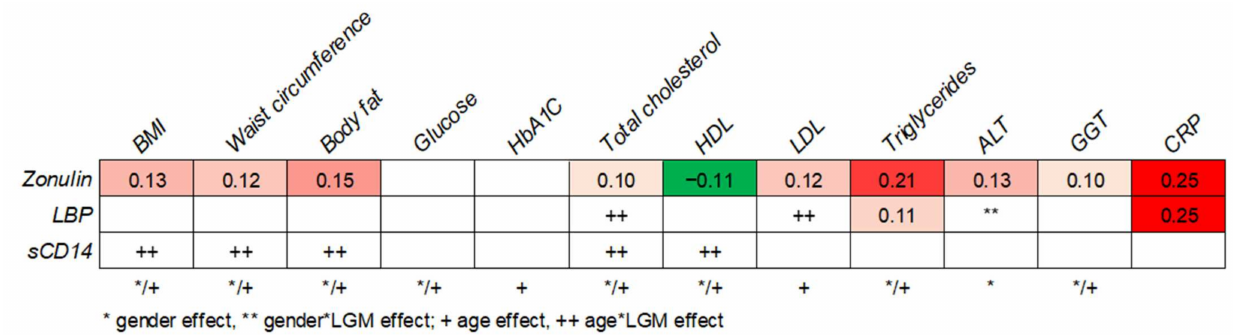
Figure 1. Stepwise linear regression analyses to test the relationship between leaky-gut markers (LGMs) and metabolic mark- ers. BMI: body mass index; HbA1c: glycated hemoglobin A1c, HDL: high-density lipoprotein, LDL: low-density lipoprotein, ALT: alanine aminotransferase, GGT: gamma-glutamyl transpeptidase, CRP: C-reactive protein, LBP: lipopolysaccharide- binding protein, and sCD14: soluble CD14.